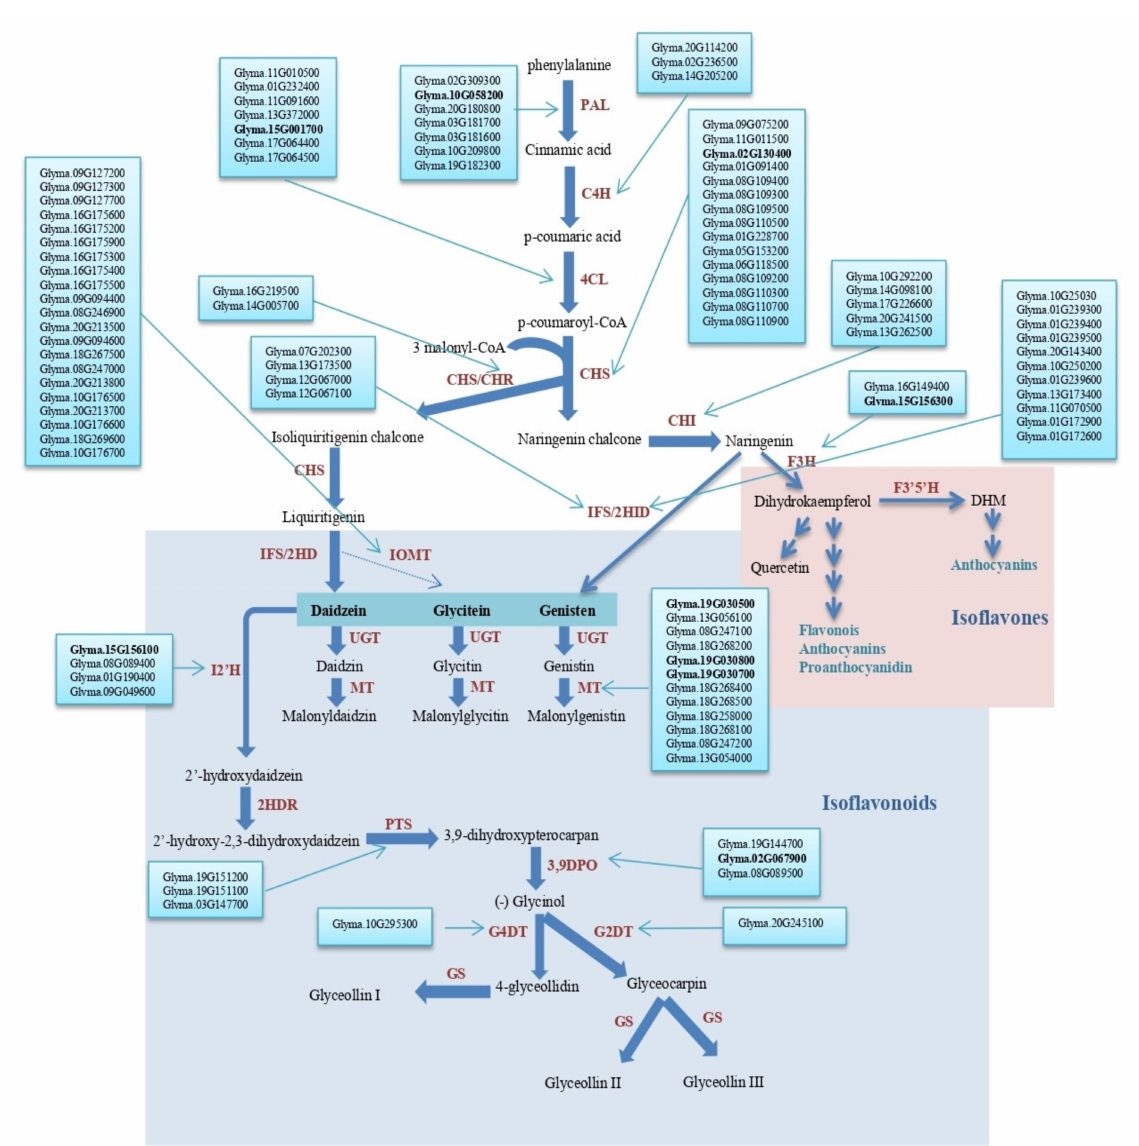
Figure 4. Seed isoflavone metabolic pathway in soybean with identified candidate genes (Vadivel et al., 2010). PAL, phenylalanine ammonia lyase; C4H, cinnamate 4-hydroxylate; 4CL, 4-coumarate-CoA ligase; CHS, chalcone synthase; CHR, chalcone reductase; CHI, chalcone isomerase; IFS, 2-hydroxyisoflavanone synthase; 2HID, 2-hydroxyisoflavanone dehydratase; IOMT, isoflavone O-methyltransferase; UGT, uridine diphosphate glycosyltransferase; MT, malonyltransferase; I2 (cid:48) H, Isoflavone 2 (cid:48) -hydroxylase; 2HDR, 2 (cid:48) -hydroxydaidzein reductase; F3H, flavanone-3-hydroxylase; F3 (cid:48) 5 (cid:48) H, flavonoid 3 (cid:48) 5 (cid:48) - hydroxylase; DHM, dihydromyricetin; PTS, pterocarpan synthase; 3,9 DPO, 3,9-dihydroxypterocarpan 6a-monooxygenase; G4DT, glycinol 4-dimethylallyltransferase; G2DT, glycinol 2-dimethylallyltransferase; GS, glyceollin